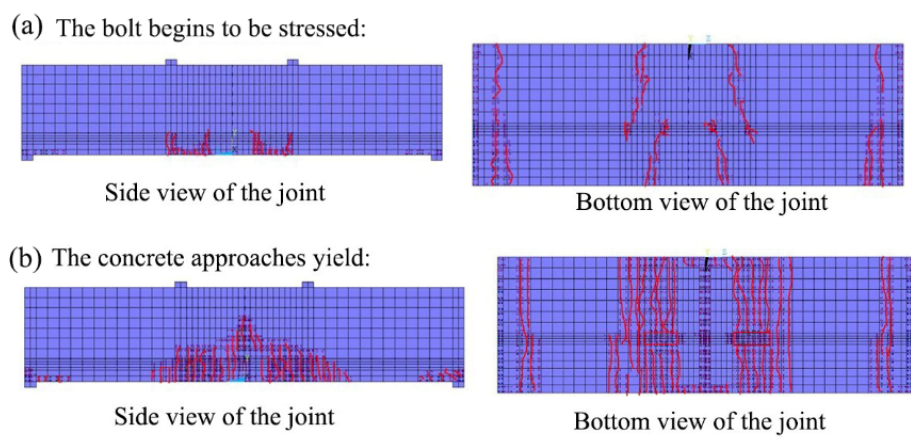
Figure 10. Crack development near the concrete hand hole segment.